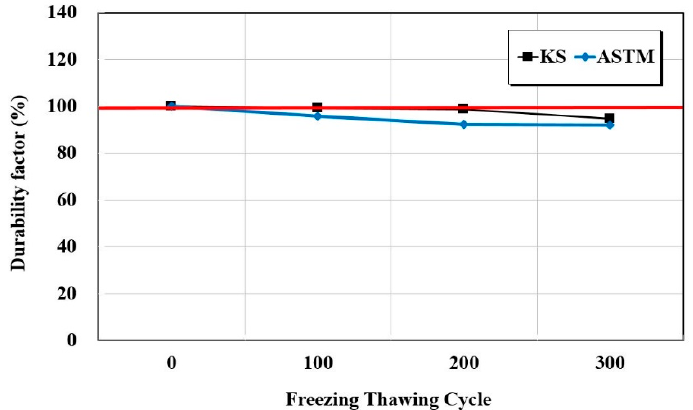
Figure 5. Durability factor test results as a function of the freezing–thawing cycle.